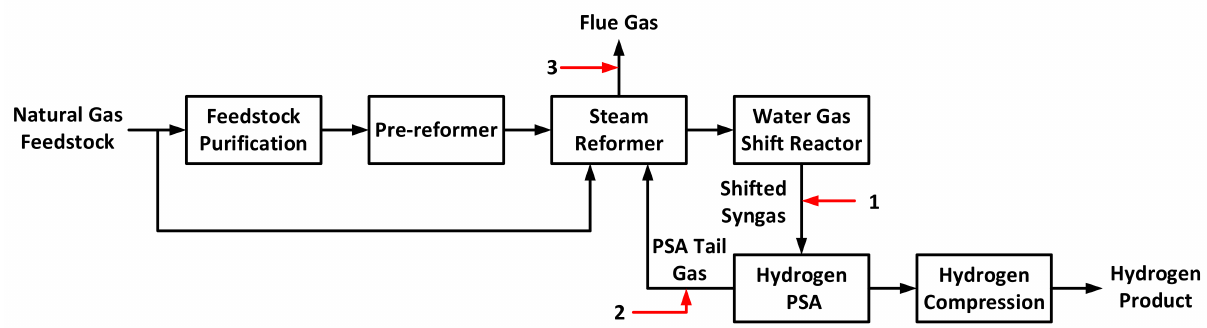
Figure 1. Block flow diagram for the SMR process. Carbon capture technologies can be applied at the locations marked with a red